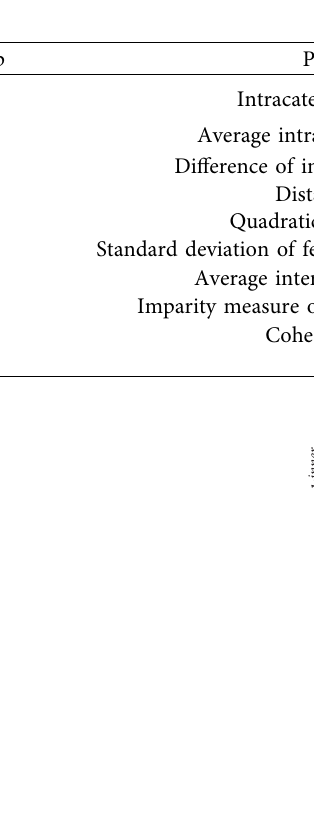
Figure 3: Cohesion evaluation.